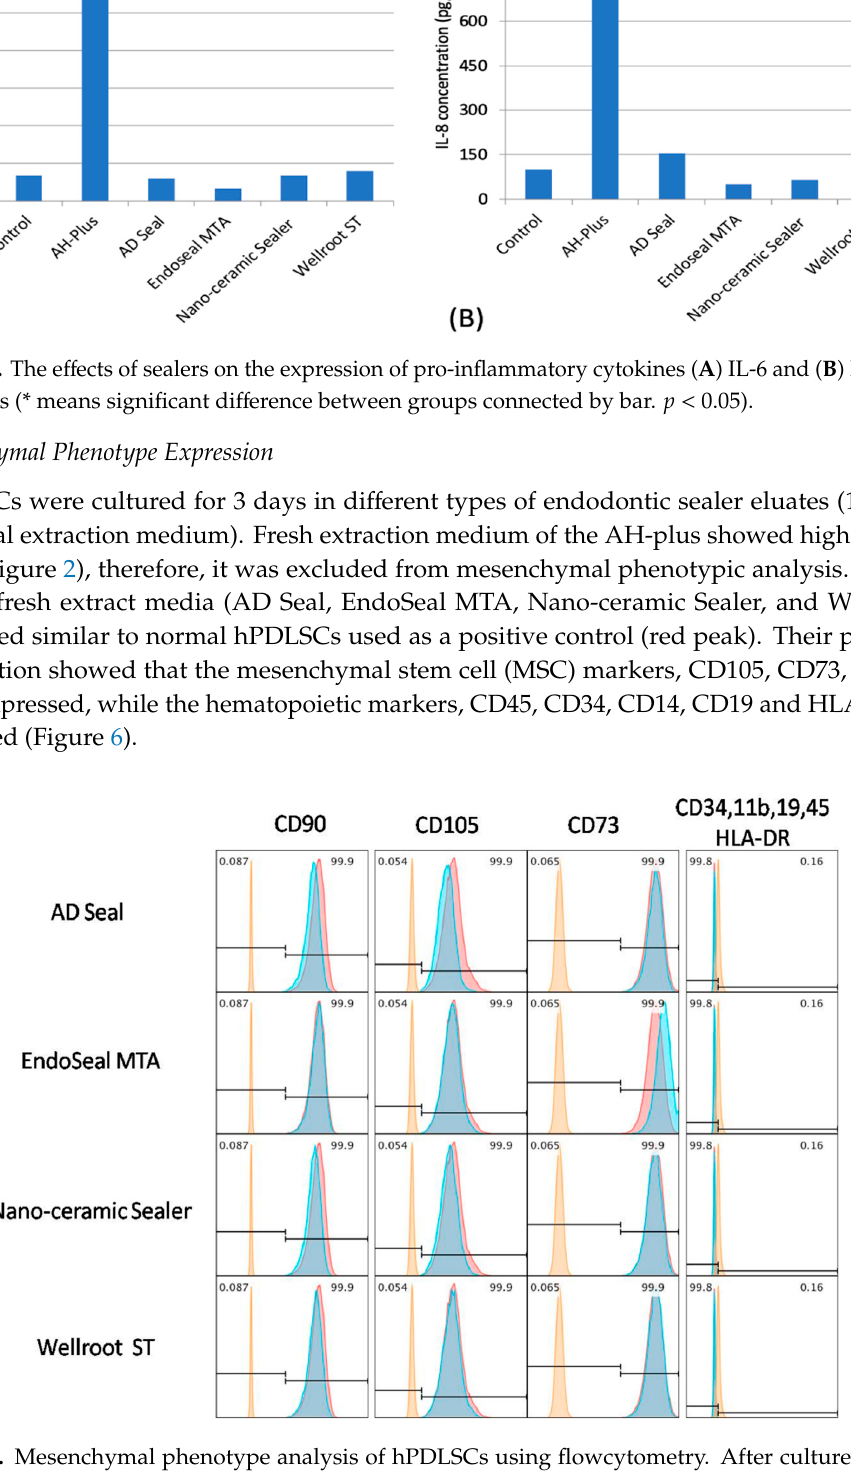
Figure 6. Mesenchymal phenotype analysis of hPDLSCs using flowcytometry. After culture in 1/4